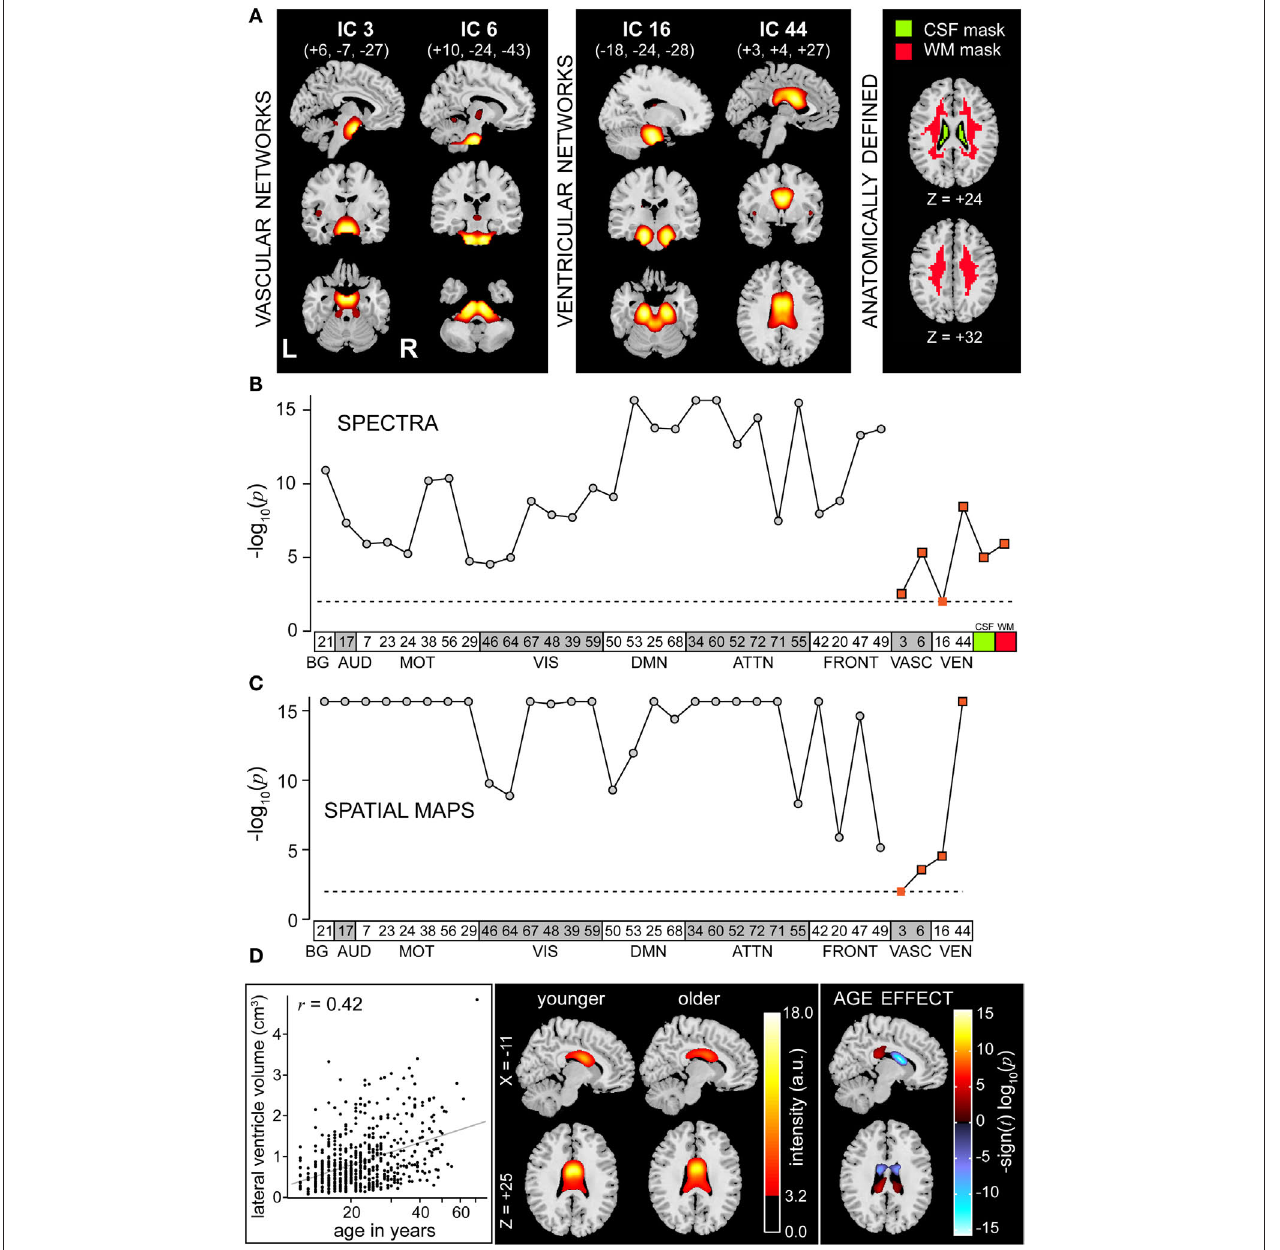
threshold ( a = 0.01, dashed line; IC 16 spectra; IC 3 SM). Note that the saturation of − log ( p ) values is due to limited computational precision; for 10 our analysis, epsilon is 2 − 52 thus − log ( p ) is maximally 15.65. (D) Origin of 10 significant age effect for the SM of IC 44 (lateral ventricles). Left panel: scatter plot of age versus lateral ventricular volume, as determined from the CSF segmented images with a probability threshold of 0.95. Middle panel: SMs of IC 44, averaged over the youngest quartile ( < 17 years, n = 134) and oldest quartile ( > 28 years, n = 137) of subjects. Right panel: statistical map of univariate results for IC 44 following the format of Figure 7 . With age, the component distribution expands more posteriorly, increasing SM intensity in the trigone of the lateral ventricles and decreasing intensity in the frontal